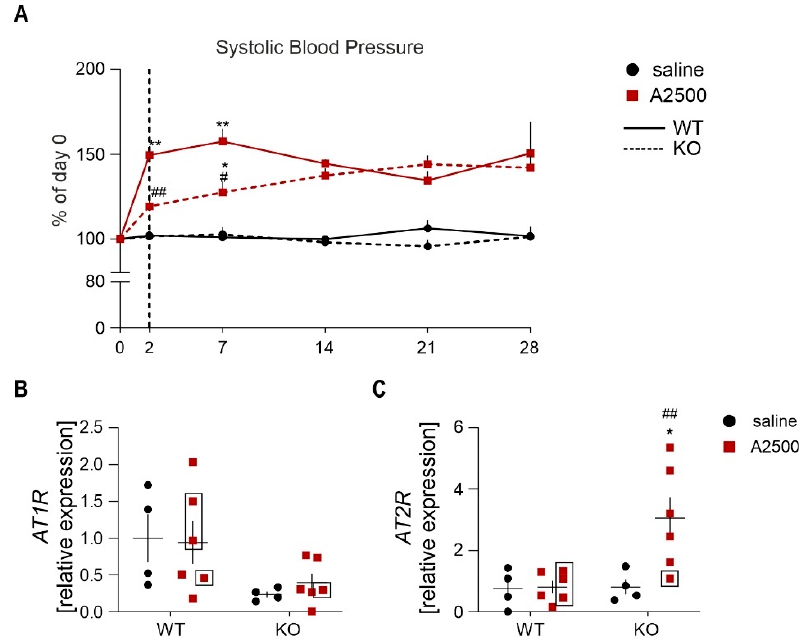
Figure 5. HO-1 deficiency delays AngII-induced abrupt blood pressure rise with concomitant changes at AT2R expression. ( A ) Time course of changes in systolic blood pressure (SBP) in WT and HO-1 KO, presented as a change of day 0; * p < 0.05 vs. saline; ** p < 0.01 vs. saline; # p < 0.05 vs. WT; ## p < 0.01 vs. WT. ( B , C ) Relative expression of ( B ) AT1R and ( C ) AT2R in the abdominal aortic wall at day 14 after placement of osmotic pumps. eEF2 was used as a reference gene. Two-way ANOVA with Tukey’s post hoc test. Rectangle—mice which developed the aneurysm. * p < 0.05 vs. saline; ## p < 0.01 vs. WT.